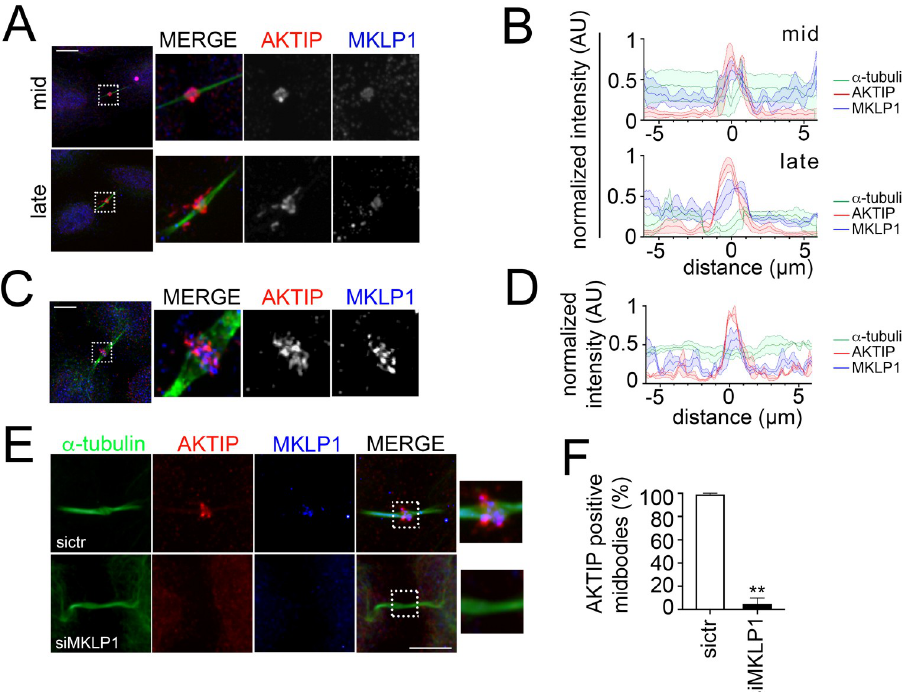
Fig 7. AKTIP recruitment to the midbody is MKLP1 dependent. (A) Spinning disk microscopy images of MKLP1 (blue), AKTIP (red) and α -tubulin (green). (B) Representative fluorescence intensity profile plotted for AKTIP, MKLP1 and α -tubulin along the midbodies at different stages; mid, n = 3; late, n = 3. (C) MSIM images of MKLP1 (blue), AKTIP (red) and α -tubulin (green). (D) Representative fluorescence intensity profile plotted for AKTIP, MKLP1 and α -tubulin along mid midbodies from (C); n = 3. (E) Representative images of sictr and siMKLP1 HeLa cells stained for AKTIP (red), MKLP1 (blue) and α -tubulin (green) showing that AKTIP recruitment is